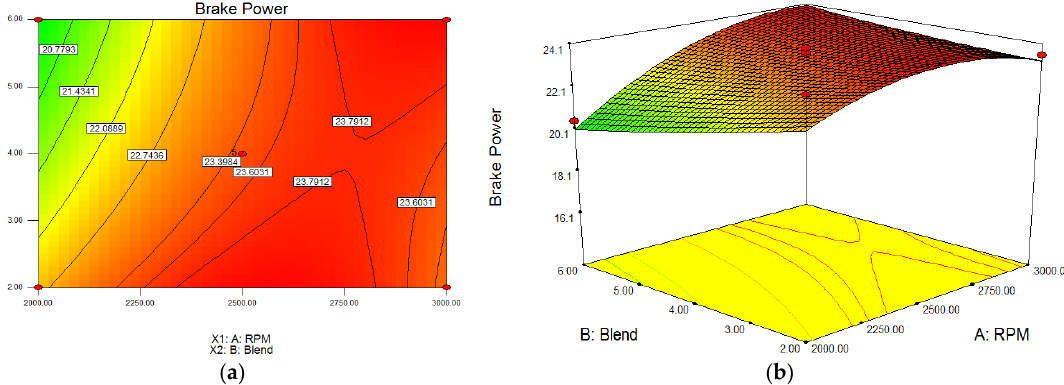
Figure 11. The interactive effect biodiesel and engine speed on the brake power. ( a ) 2D contour plots; and ( b ) 3D response surface plot.